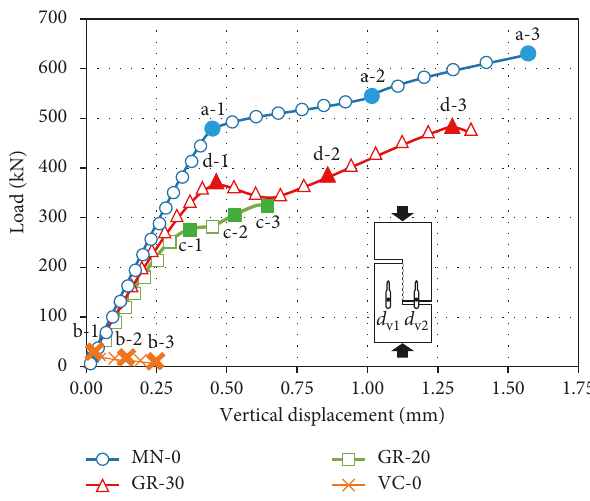
Figure 10: Load-vertical displacement results. Table 6: Measured shear strengths for the UHPC construction joint